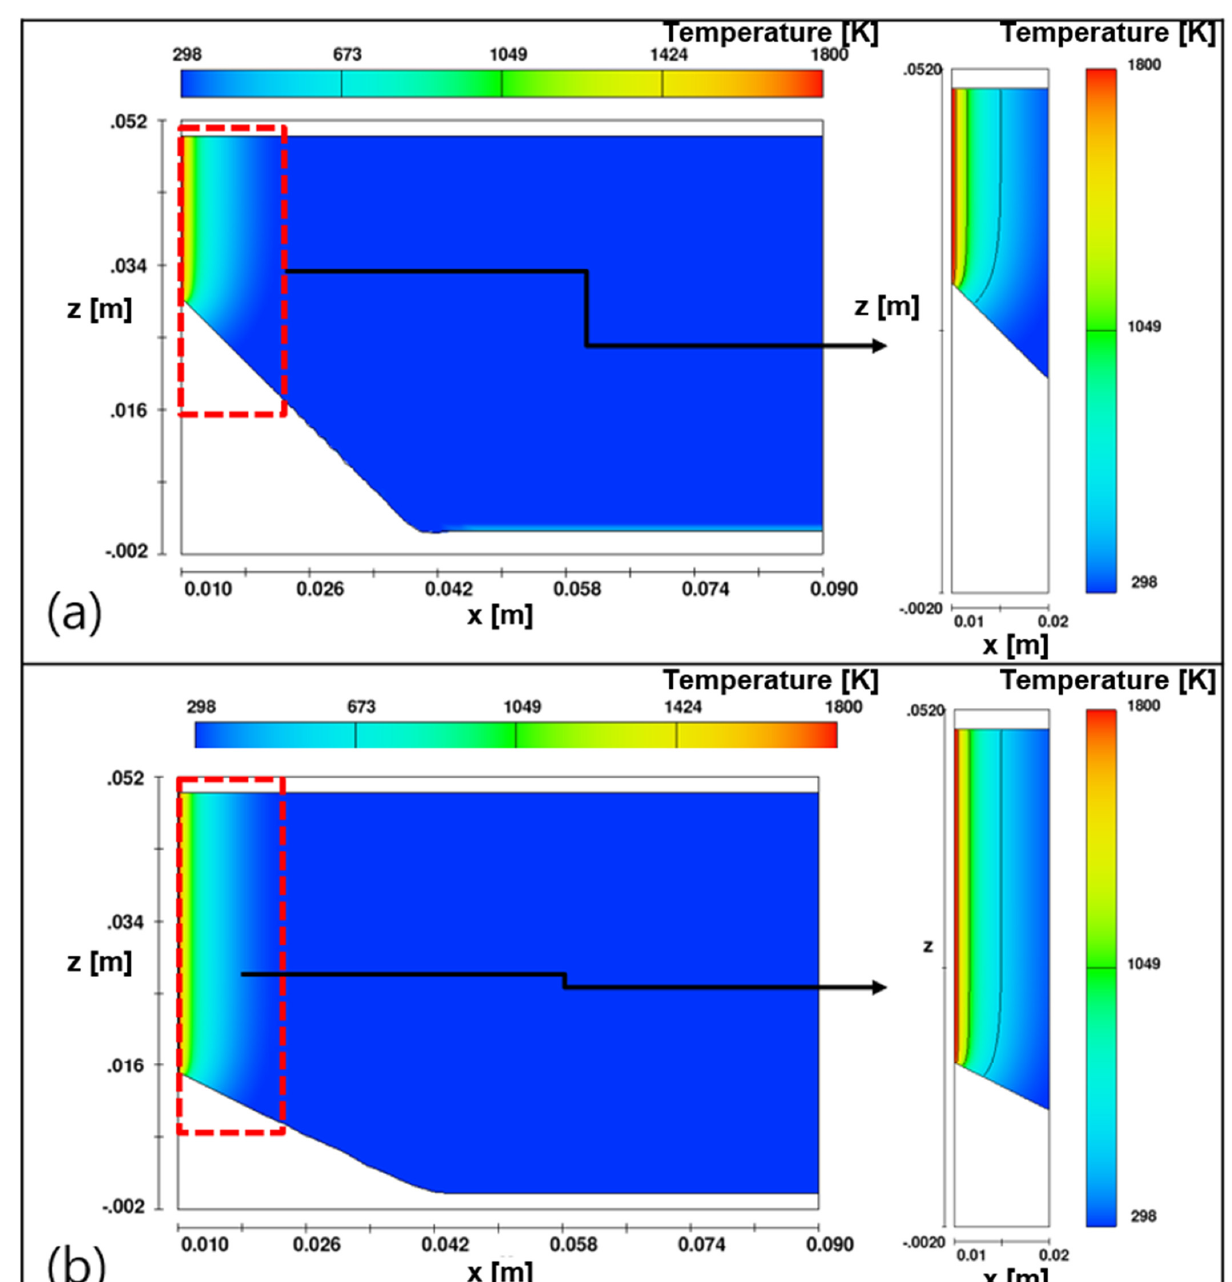
Figure 12. Laser cutting simulation result of cutting surface. ( a ) Cut surface at 10 mm in the x-direction of case 2 ( b ) Cut at 10 mm in the x-direction of case 4.